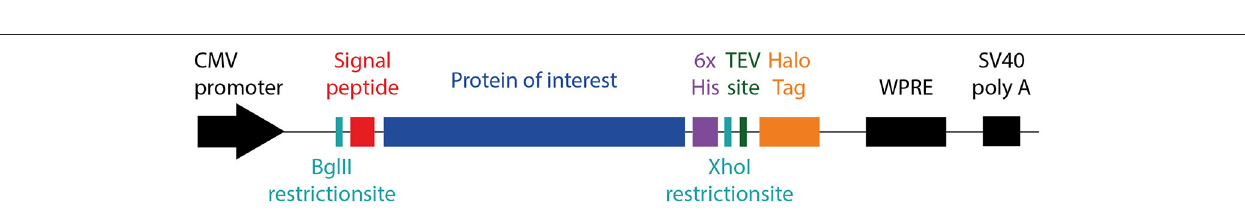
FIGURE 2 | Schematic illustration of the direct and HaloTag coupling to the MagPlex microspheres . (A) We refer to direct coupling when the amino group of the protein is directly coupled to the carboxylated microsphere. (B) For the HaloTag coupling a HaloTag amine ligand serves as a connection between the carboxyl group and the HaloTag of the protein. Due to this indirect coupling, the protein of interest is freely accessible compared to the direct situation. Part of the figure is adapted from Promega.